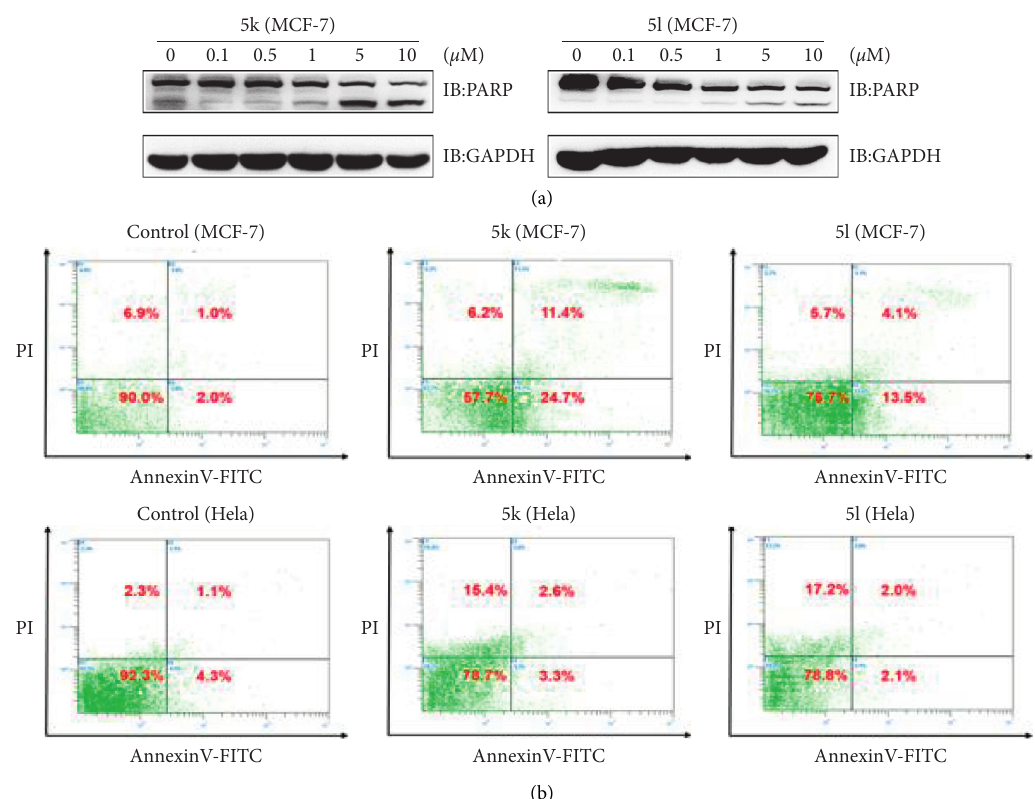
Figure 4: Apoptosis induction by compounds 5k and 5l. (a) Western blot analysis of PARP in MCF-7 cells treated with different concentrations of compounds 5k and 5l . (b) Annexin V/PI staining of MCF-7 cells and Hela cells treated with 10 μ M 5k and 5l for